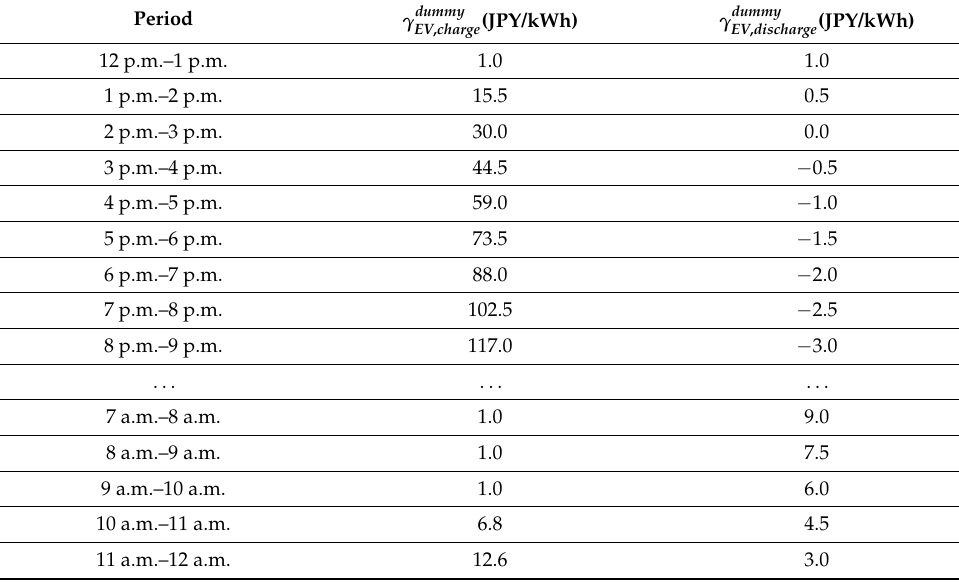
Table A2. Dummy prices for controlling EV